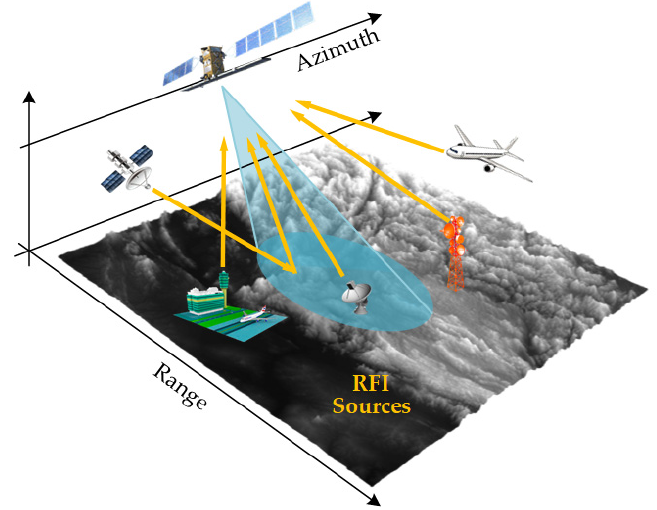
Figure 1. Common sources and geometric model of RFI.